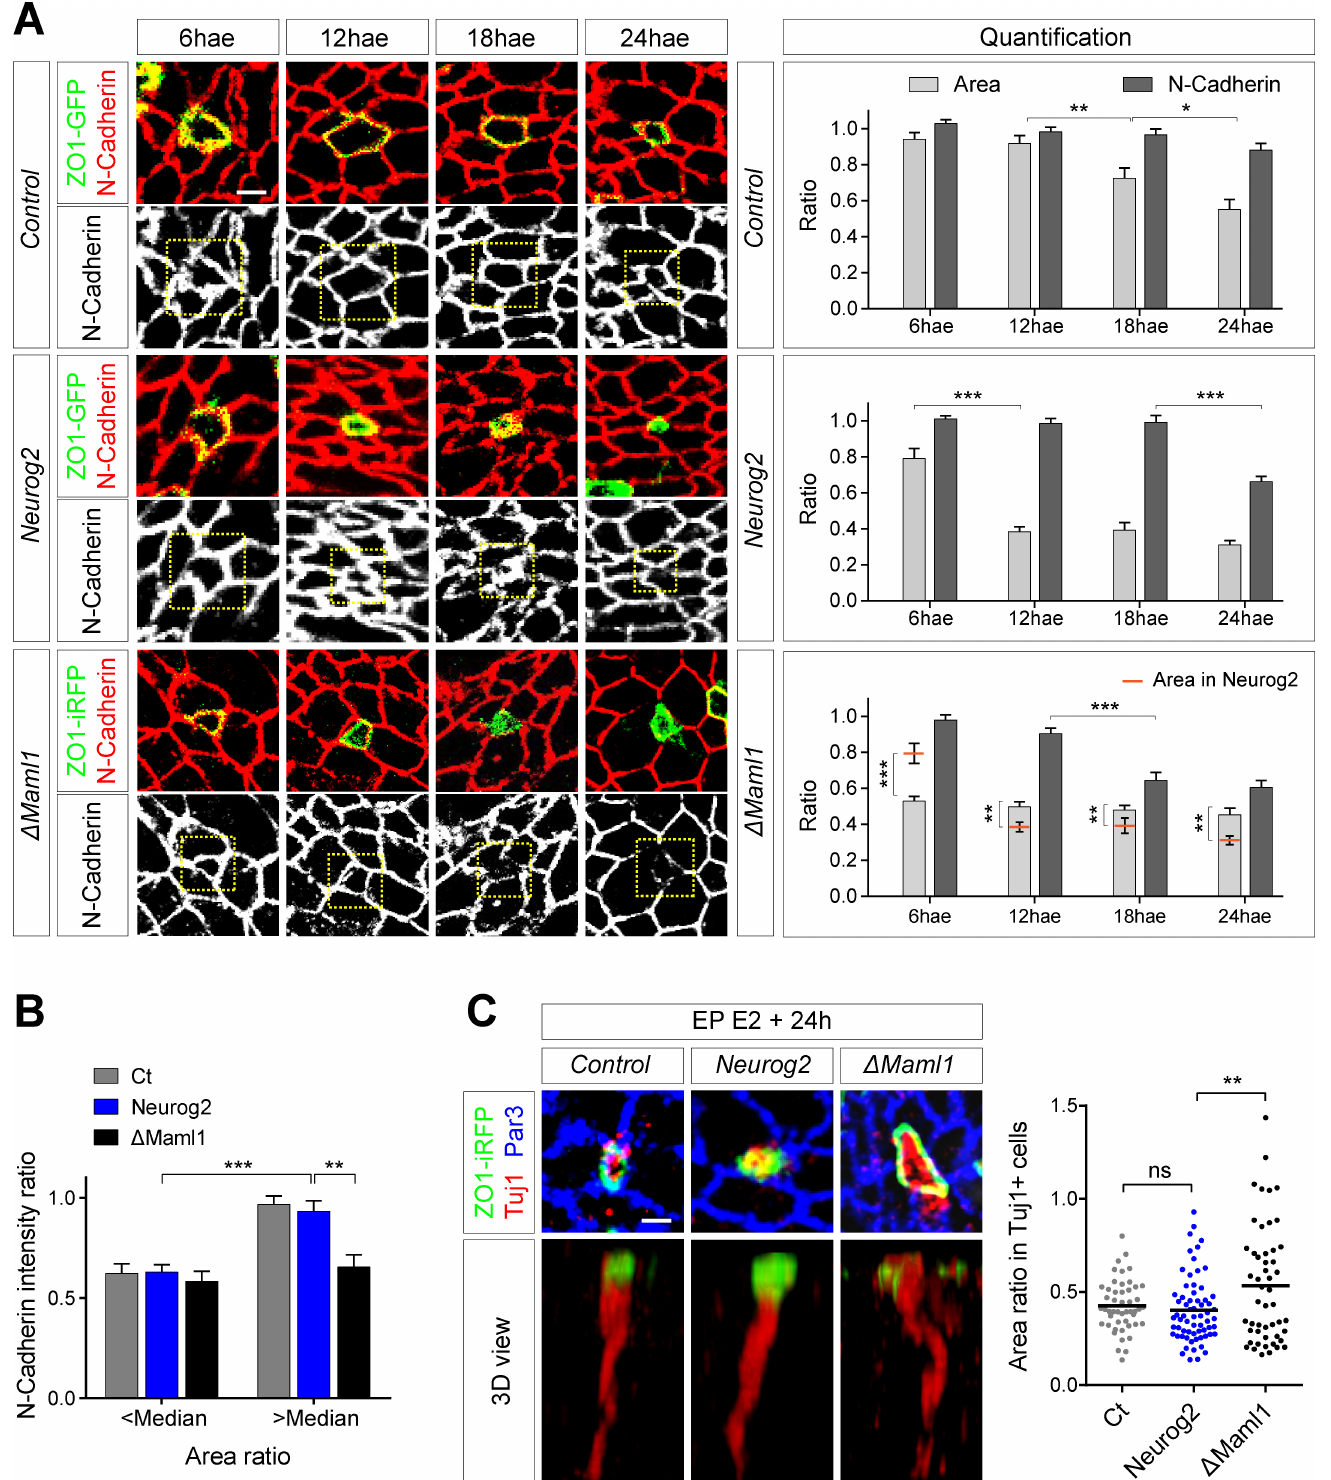
Fig 2. Sequence of events leading to neuron delamination. (A) Left: Apical view of the NT electroporated at E2 with ZO1-GFP/iRFP (green), along with the constructs indicated on the left, and harvested at different hae, followed by an immunostaining for N-Cadherin. The boxed area indicates the cell of interest. Right: Quantification of the apical area ratio (ratio of the area of one transfected cell versus the mean area of four of its close non-transfected neighbors) and N-Cadherin